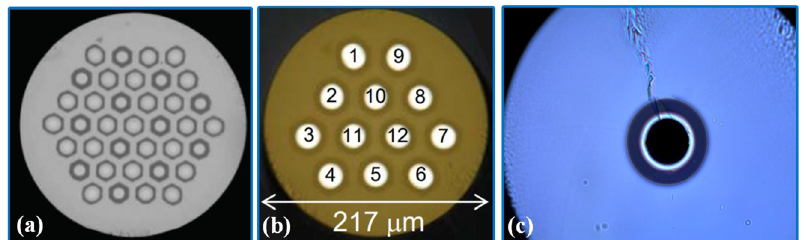
Figure 20: Optical microscope photo of (a) MCF with single-mode 37 cores [237]; (b) FM-MCF with 12 hexagonally arranged 10-mode cores [240]; (c) OAM fi ber sup- porting36OAMstates[243].MCF,multicore fi bers; FM-MCF, few-mode multicore fi ber; OAM, orbital angular